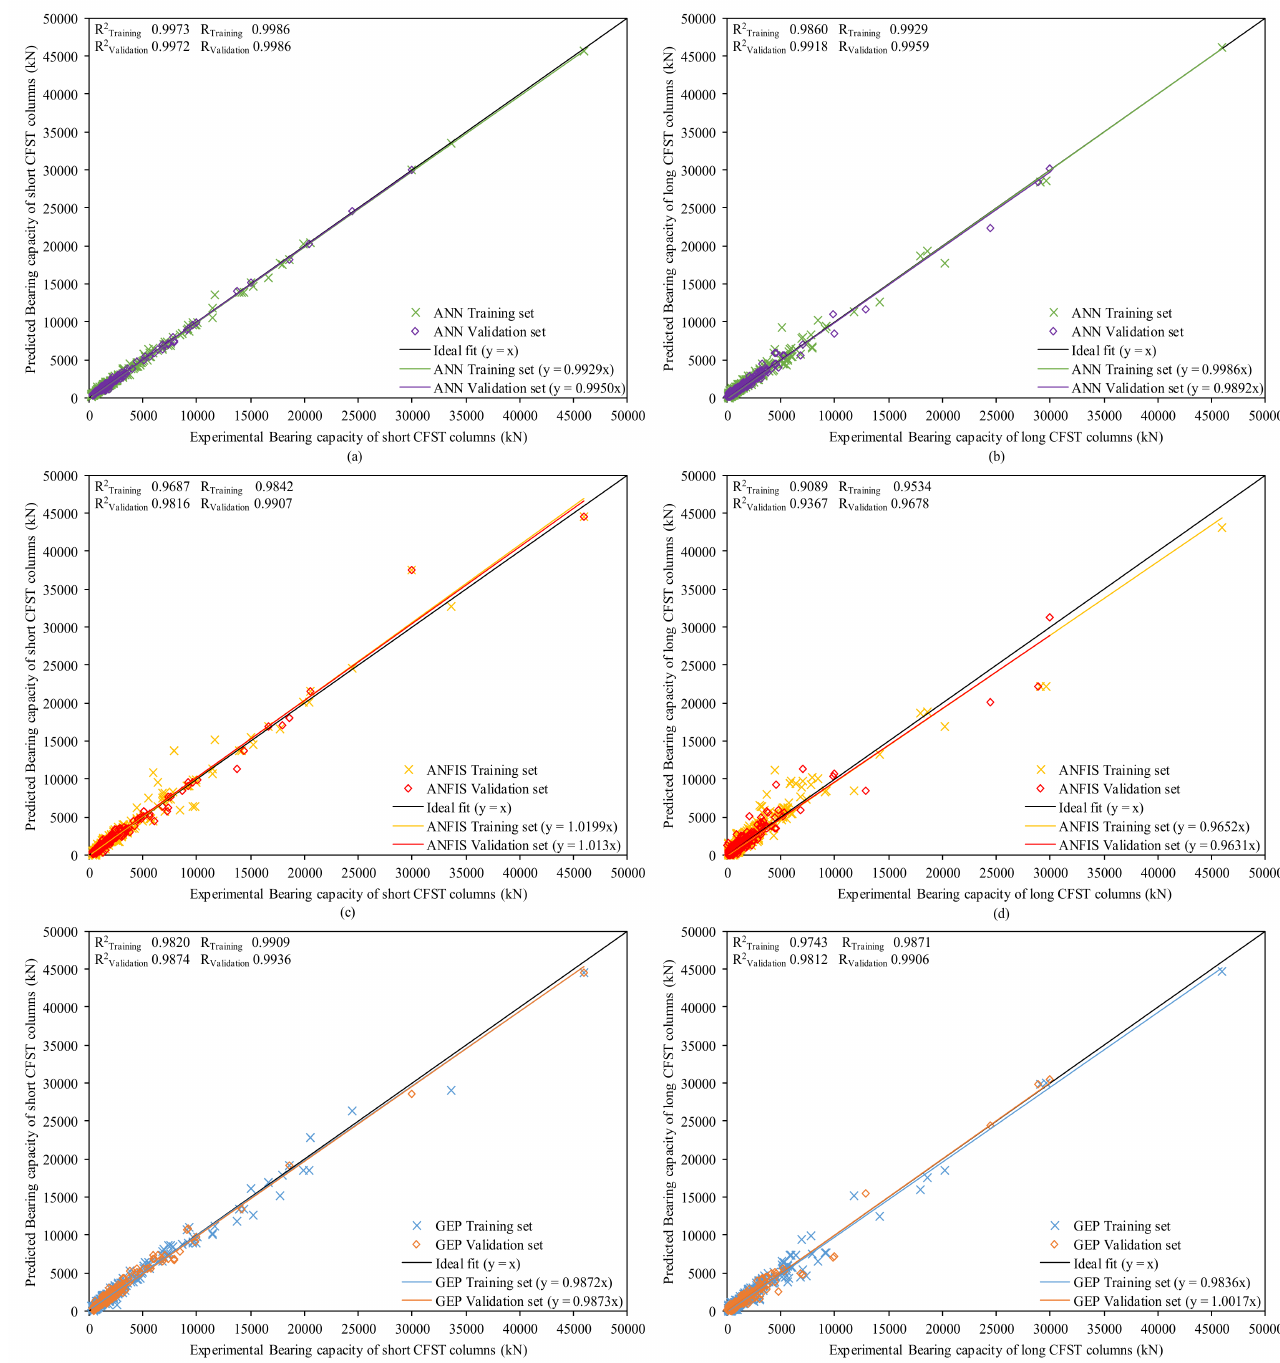
Figure 5. Regression plot between actual and predicted bearing capacity of ( a ) ANN model for short CFST columns ( b ) ANN model for long CFST columns ( c ) ANFIS model for short CFST columns ( d ) ANFIS model for long CFST columns ( e ) GEP model for short CFST columns and ( f ) GEP model for long CFST